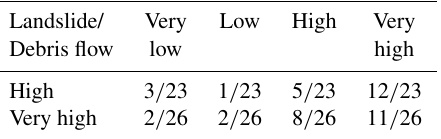
Table 5. The overlap of the number of debris flow and landslide high- and very-high-class mapping units.